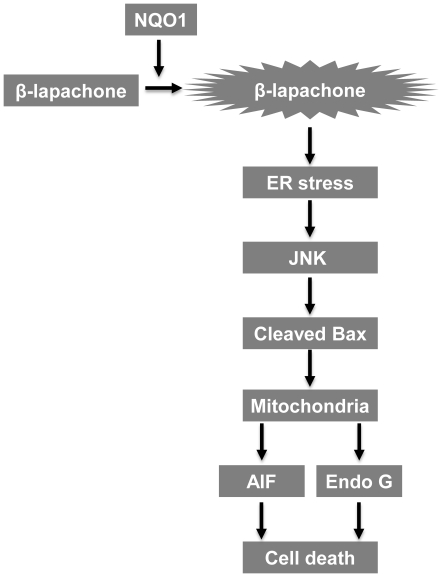
Schematic model of mitochondria-mediated cell death triggered by β-lap.β-lap induces mitochondrial apoptotic cell death in a NQO1-dependent manner. The induction of ER stress by β-lap is substantially required for JNK activation which triggers mitochondria-mediated cell death pathway. In detail, JNK activation induces cleavage of Bax and mitochondrial translocation of cleaved Bax, which causes disruption of mitochondrial membrane potential, and subsequent nuclear translocation of AIF and Endo G. Understanding these signaling pathways that we elucidated in this study may provide useful insights into improvement in therapeutic efficacy of the design of NQO1-targeted cancer therapies.